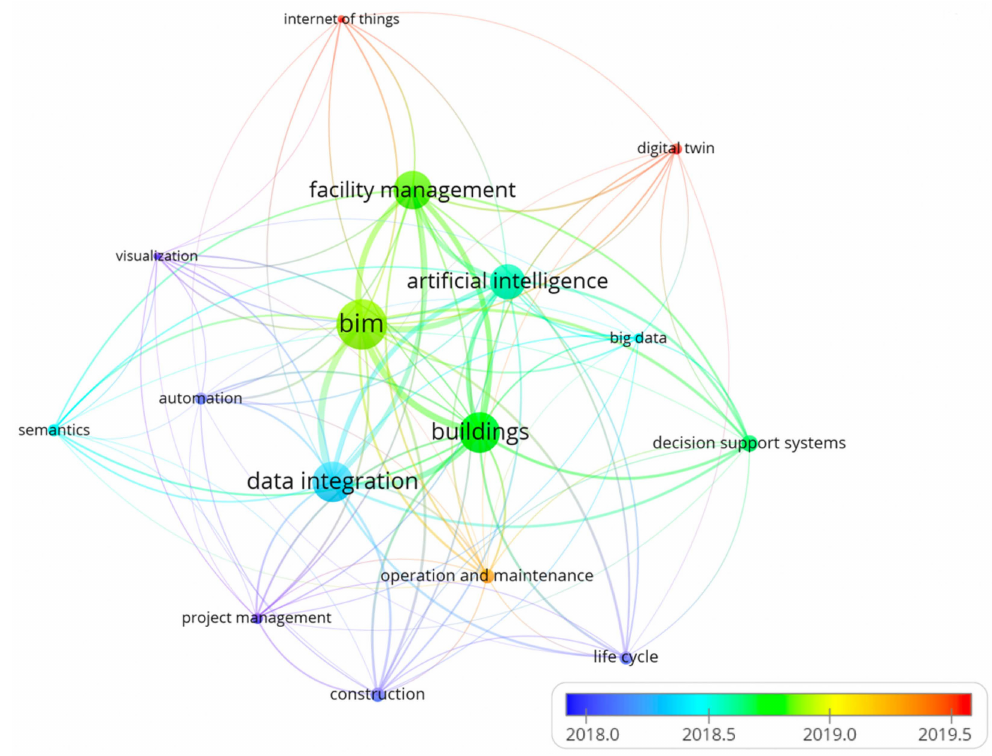
Figure 5. The current occurring keywords map per